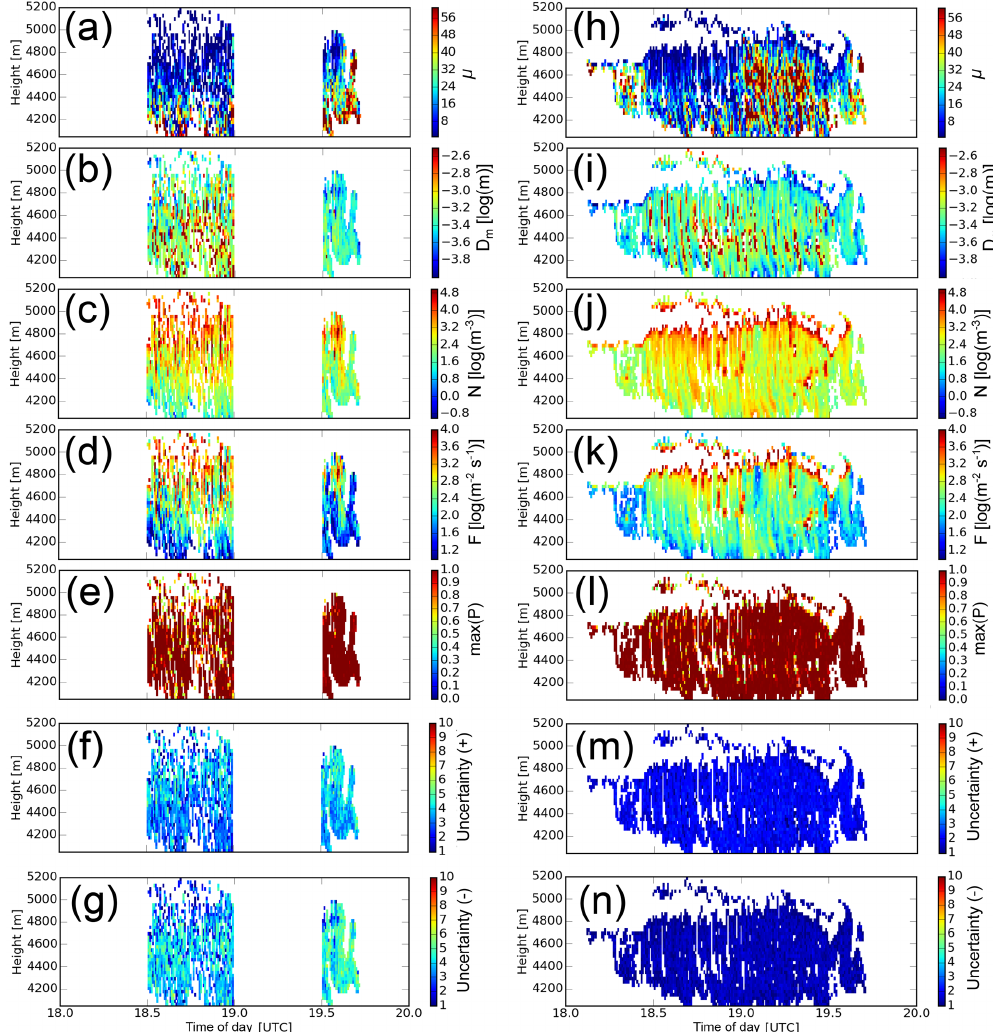
Figure 8. Results of the retrieval based on v t and w (left column) and Z/E and w (right column) for the particle type plate-like. Combined CR/RWP measurements are only available in the second half of each hour. Different retrieved parameters are shown: (a, h) spectral width parameter µ , (b, i) median diameter D m , (c, j) number concentration N and (d, k) particle number flux F . Maximum probability of P for each retrieval (e, l) is shown together with the upper (f, m) and lower (g, n) uncertainty factors for the retrieved